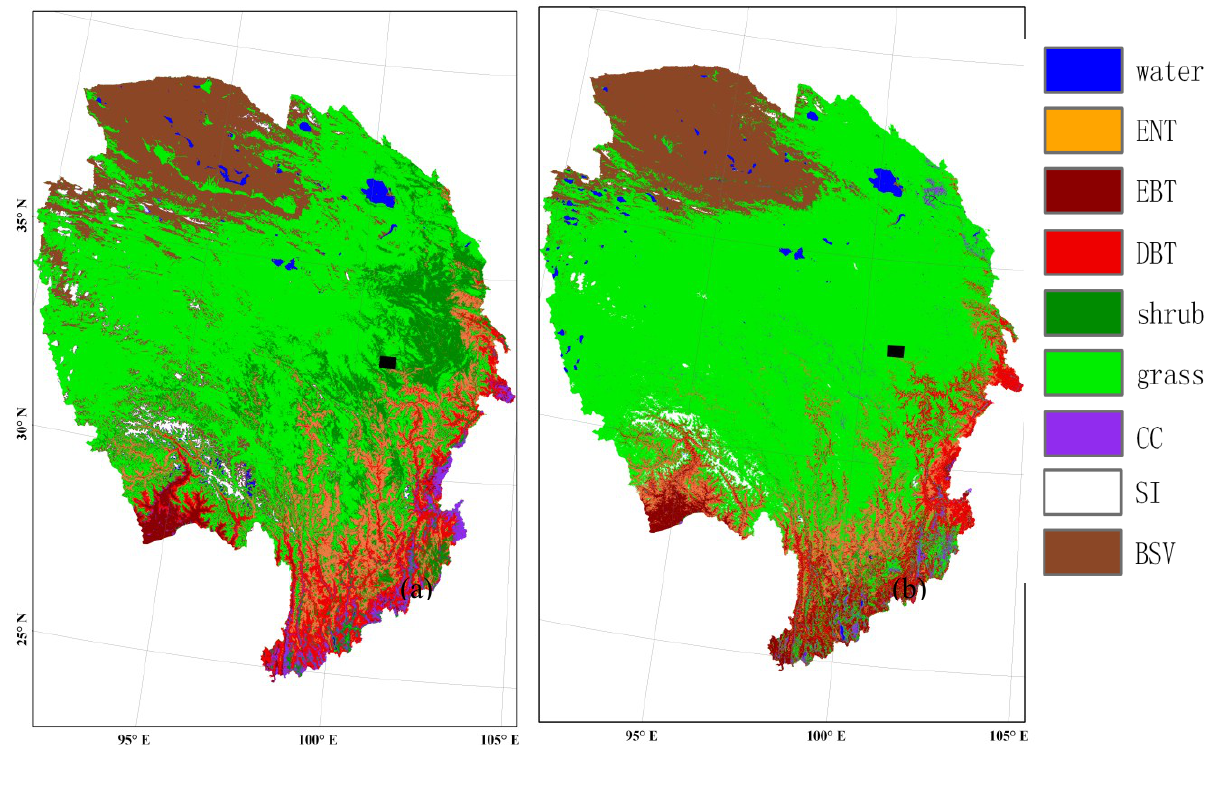
Figure 5. Comparison of ( a ) phenological hierarchical classification and ( b ) MODIS 2007 PFT for eastern Tibetan Plateau. Vegetation types represented by initials: evergreen needle leaf trees (ENT), evergreen broad leaf trees (EBT), deciduous needle leaf trees (DNT), deciduous broad leaf trees (DBT), shrub, grass, crop (CC), snow and ice (SI), barren or sparse vegetation